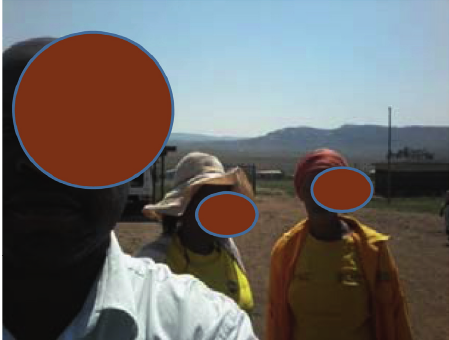
Figure 6: School and the EPWP programme: site